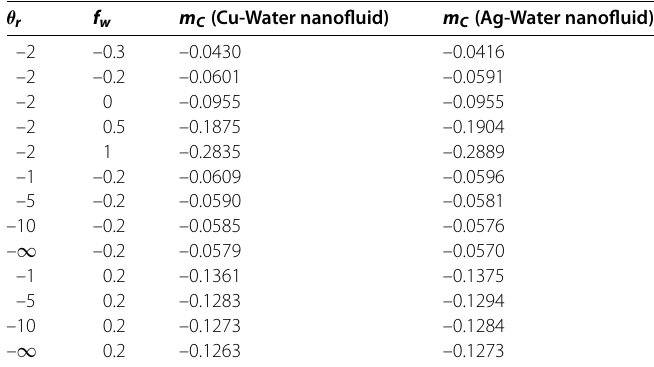
Table 3 Critical values m C with representative values of f w or θ r when φ = 0.05, P r = 6.2, M =